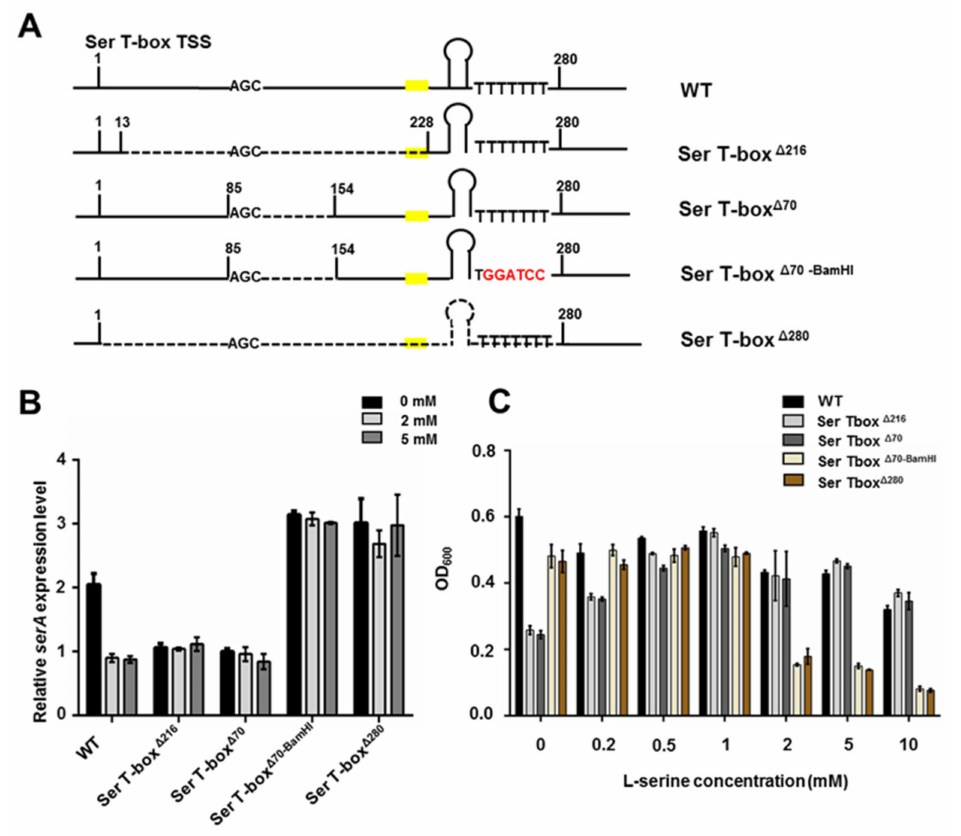
Figure 7. Scheme of mutation of the Ser T-box and the effects on growth and serA expression. ( A ) A scheme of mutation of the Ser T-box. The Ser T-box riboswitch is 280 bp in length. The number 1 is the start site of transcription and is also the start site of the Ser T-box riboswitch. The number represents the position of Ser T-box, the dotted line represents the deletion region and red-labeled nucleotides represent the BamHI mutation region. AGC represented the specifier codon and the yellow box represented the position of the 14-bp T-box sequence. ( B ) qRT-PCR analysis of the serA expression level of WT, Ser T-box ∆ 70 , and Ser T-box ∆ 70-BamHI strains grown on nitrogen-limited medium with 0, 2, and 5 mM concentrations of L-serine. ( C ) The growth of WT ( P. polymyxa WLY78) and mutants grown under minimal medium containing 0–5 mM L-serine, and the OD 600 was measured after 16 h growth within stationary phases. Results are representative of at least three independent experiments, mean values ± SDs were calculated from three sets of independent